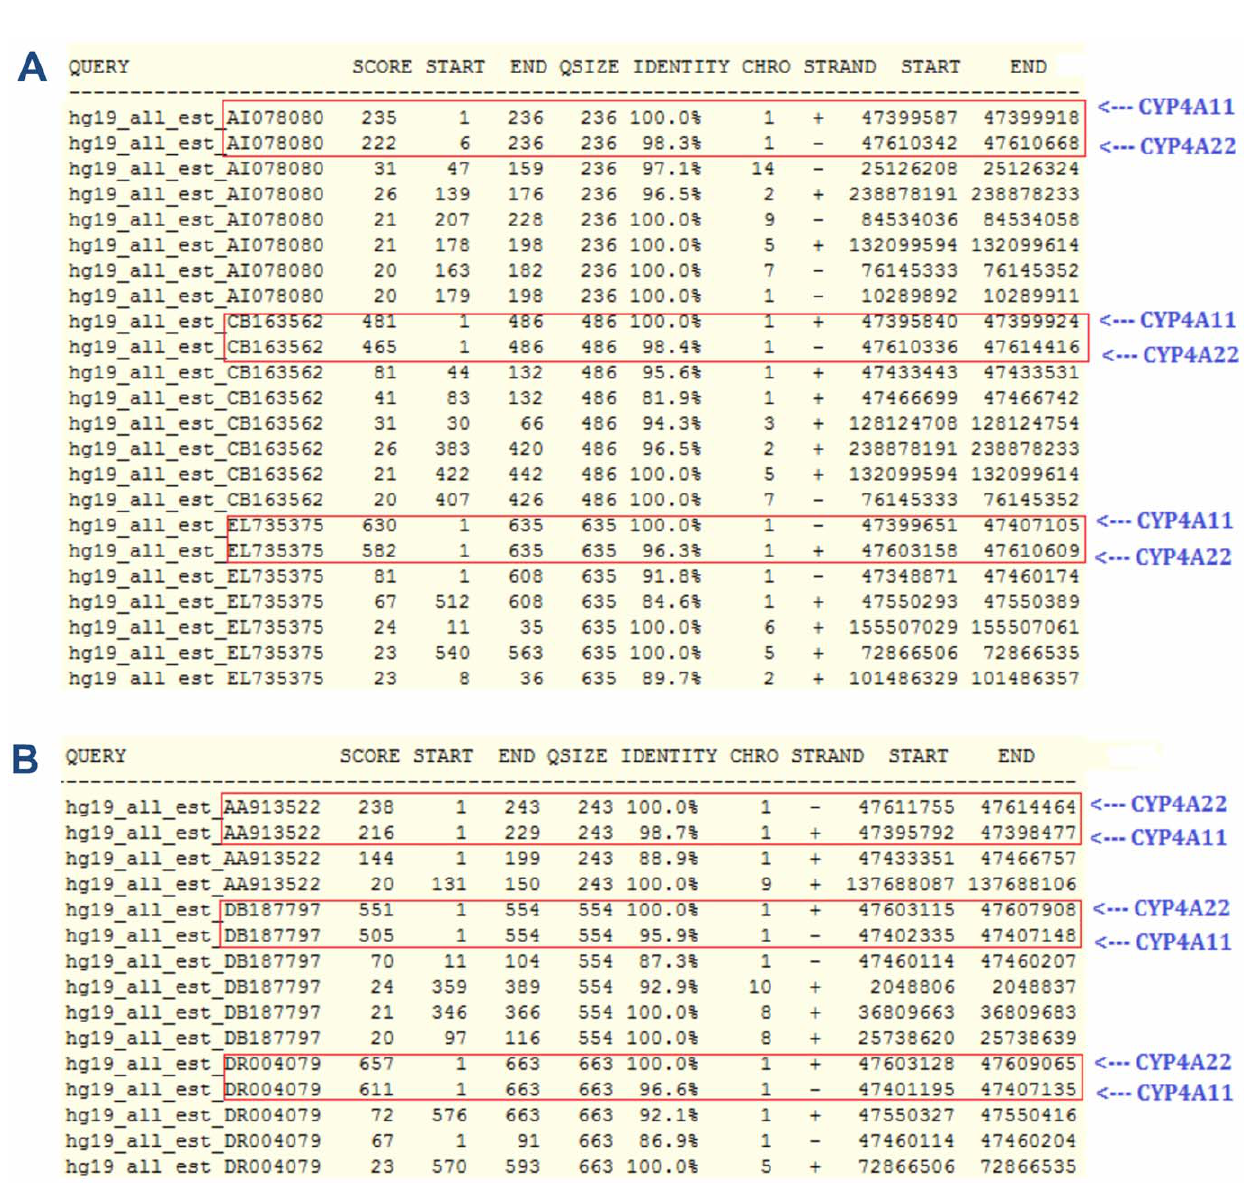
Figure 8. The BLAT scores for (A) three ESTs from CYP4A11 gene and (B) three ESTs from CYP4A22 gene. (A) indicates all three ESTs (AI078080, CB163562, EL735375) obtain highest BLAT scores (235, 481, 630) in their own gene, and record their second highest BLAT scores in the CYP4A22 gene. (B) shows the BLAT scores obtained by the three ESTs (AA913522, DB187797, DR004079) from the CYP4A22 gene. These three ESTs also yield the highest BLAT scores in their own gene, and their second highest BLAT scores can be traced in the CYP4A11